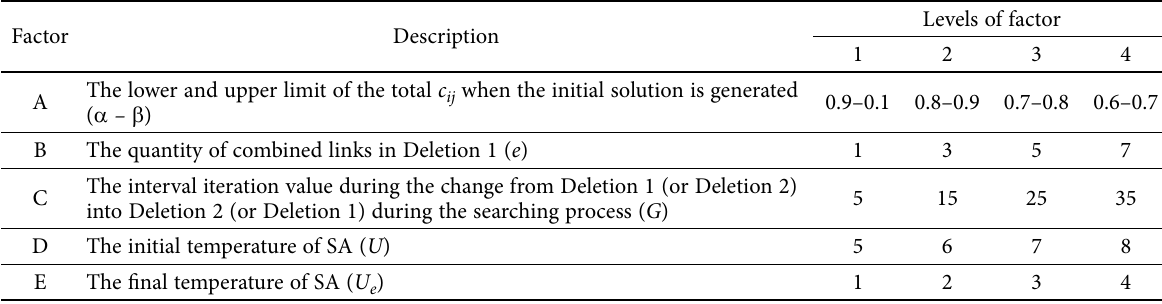
Table 1. The experimental levels of parameters